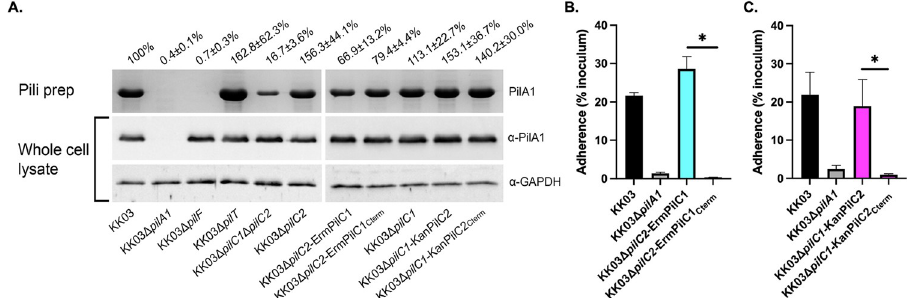
Fig 4. The PilC1 and PilC2 C-terminal domains promote production of pilus fibers that lack adhesive activity. (A) Sheared pili fractions or whole cell sonicates of strains KK03, KK03 Δ pilA1 , KK03 Δ pilF , KK03 Δ pilT , KK03 Δ pilC1 Δ pilC2 ,KK03 Δ pilC2 , KK03 Δ pilC2- ErmPilC1, KK03 Δ pilC2- ErmPilC1 Cterm , KK03 Δ pilC1 , KK03 Δ pilC1- KanPilC2, and KK03 Δ pilC1 -KanPilC2 Cterm were boiled and separated using SDS-PAGE. KK03 Δ pilF lacks the PilF assembly ATPase and does not assemble PilA1 into pilus fibers. For pili preps, the PilA1 pilin monomer band was stained with Coomassie blue. For whole cell lysates, the PilA1 pilin monomer band was detected by Western blot analysis using polyclonal antiserum GP65 [52] to PilA1. GAPDH was detected by Western blot analysis to control for total protein using polyclonal antiserum CHP-GP22. The values above the gel and blot images are densitometry measurements of the PilA1 band from the sheared pilus preparations (pili prep) gel that were normalized to the α - GAPDH band intensities and are expressed as a percentage of the band intensity of the wild type strain KK03. The densitometry values are listed ± standard error of the mean from three biological replicates, and representative gel and blot images are shown. (B, C) Strains KK03, KK03 Δ pilA1 , KK03Erm Δ pilC2- PilC1, KK03 Δ pilC2- ErmPilC1 Cterm , KK03 Δ pilC1- KanPilC2, and KK03 Δ pilC1 -KanPilC2 Cterm were added to monolayers of Chang epithelial cell of HeLa origin and evaluated for adherence. Percent adherence was calculated based on the ratio of recovered bacteria to the inoculum. Error bars represent standard error of the mean, n = 3. Cyan color denotes strains expressing either full- length PilC1 or the C-terminal region of PilC1 only. Magenta color denotes strains expressing either full-length PilC2 or the C-terminal region of PilC2 only. � indicates significance of P < 0.05 as determined by a one-way ANOVA using Bonferroni correction for multiple comparisons.